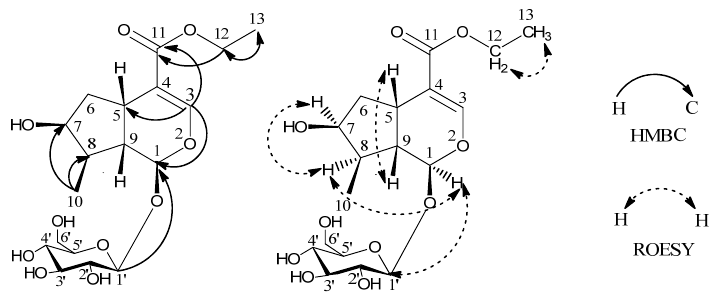
Figure 2. Key HMBC and ROESY correlations of 1 .